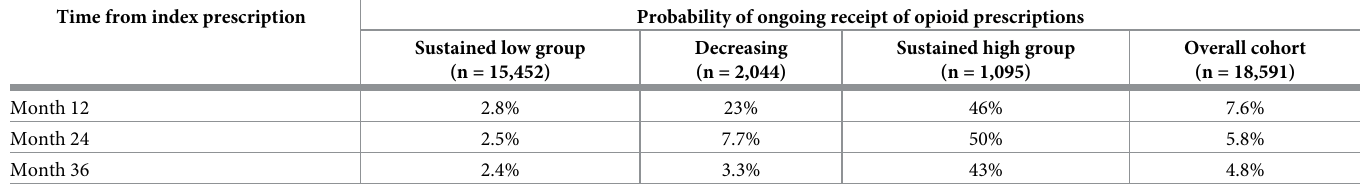
Table 2. Proportion of the training cohort (2010–11) still receiving opioid prescriptions at 12, 24, and 36 months after their index prescription, stratified by trajec- tory